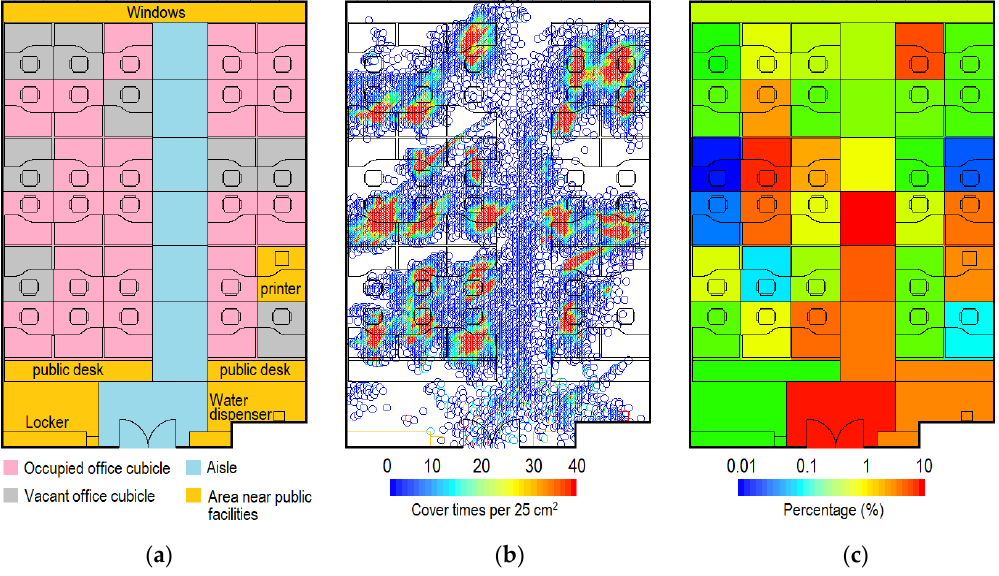
Figure 3. Indoor positioning in Room 2 ( day 2 ). ( a ) Functional area; ( b ) Distribution of indoor positions; ( c ) Distribution of indoor positions by functional area during the time spent in other places (i.e., students outside their own cubicles). (Indoor positioning data for students 3-4 and 3-5 were lost).